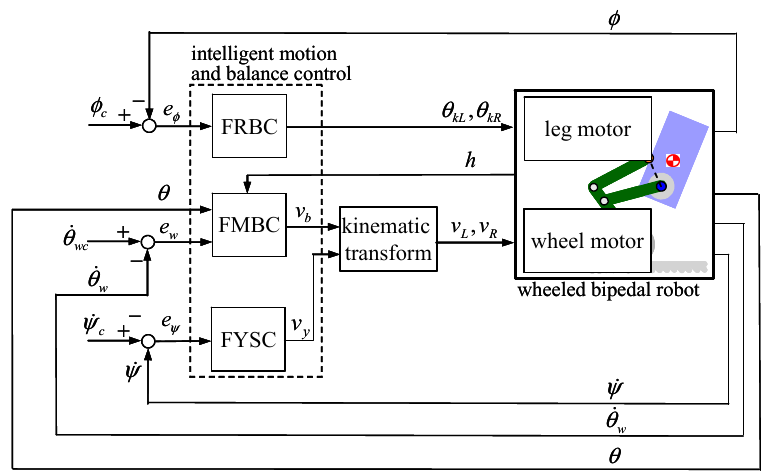
Figure 4. The block diagram of the IMBC system for the WBR.